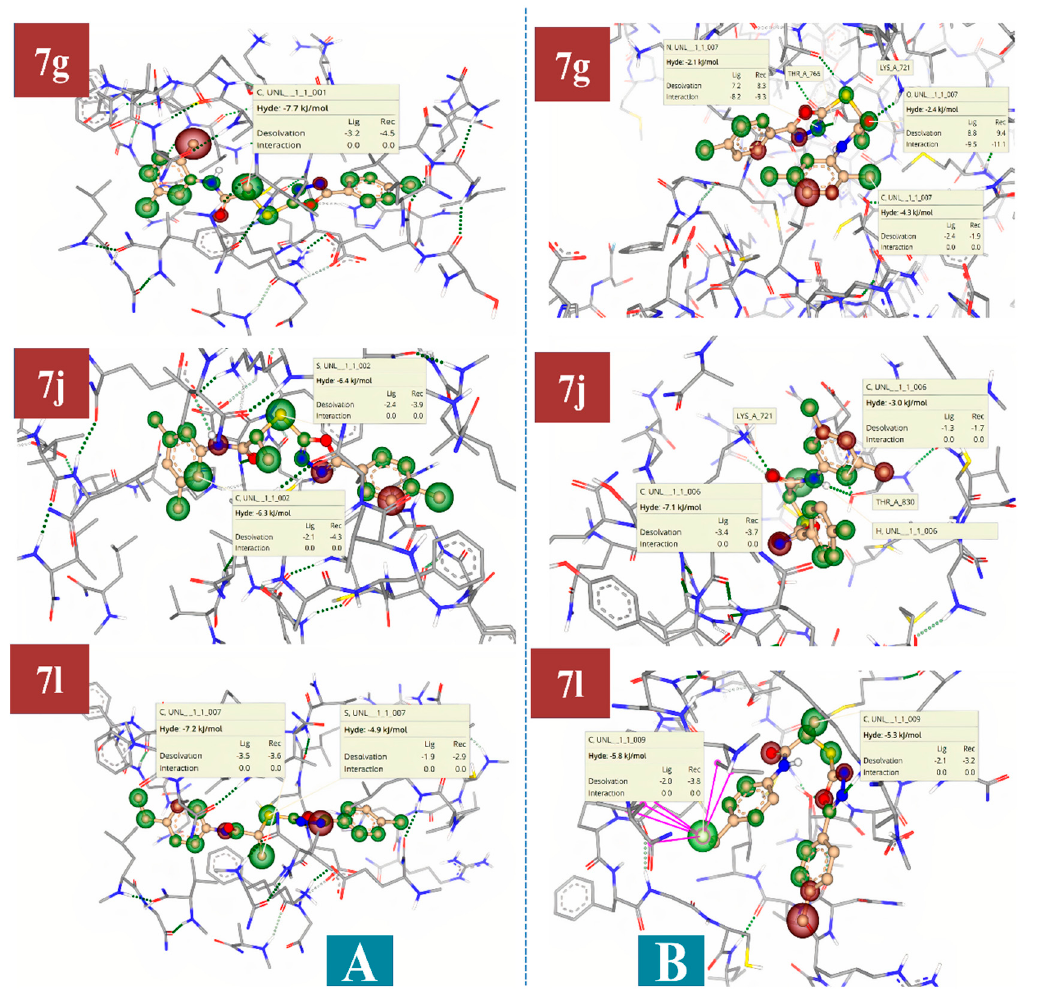
Figure 8. SeeSAR analysis of the most potent compounds with both proteins: ( A ) VEGFR; and ( B ) EGFR.